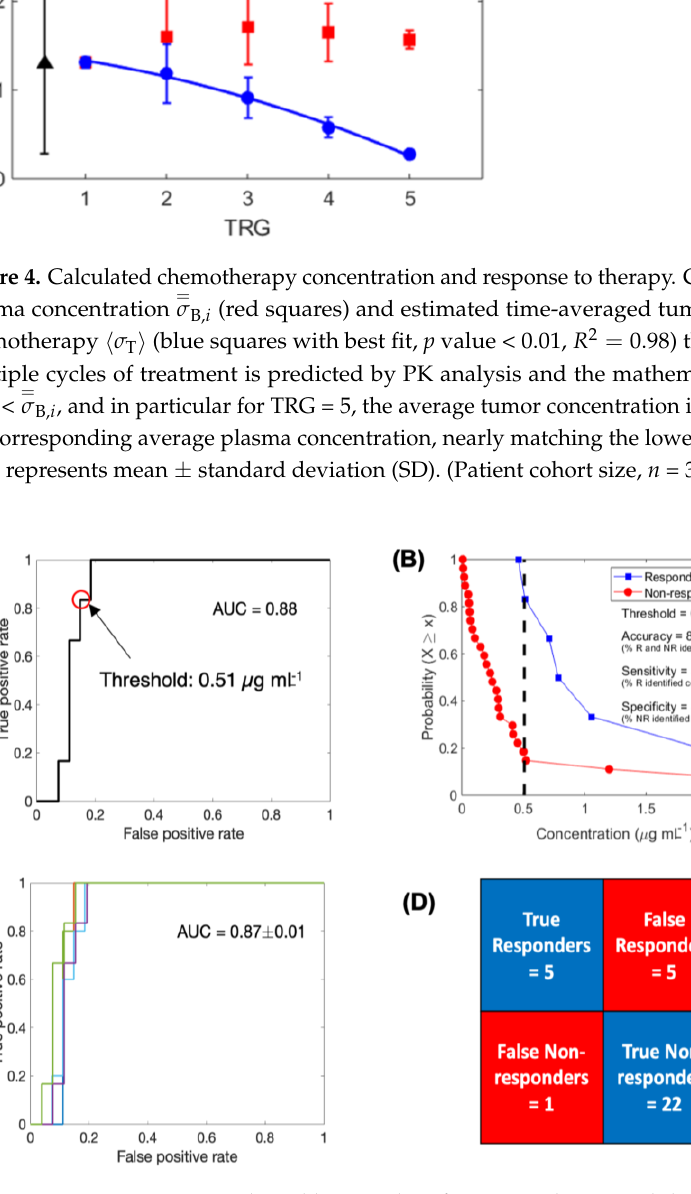
Figure 4. Calculated chemotherapy concentration and response to therapy. Calculated time-aver- aged plasma concentration 𝜎̿ B (red squares) and estimated time-averaged tumor-site concentra- tion of chemotherapy 〈𝜎 T 〉 (blue squares with best fit, p value < 0.01, 𝑅 2 = 0.98 ) throughout the course of multiple cycles of treatment is predicted by PK analysis and the mathematical model.